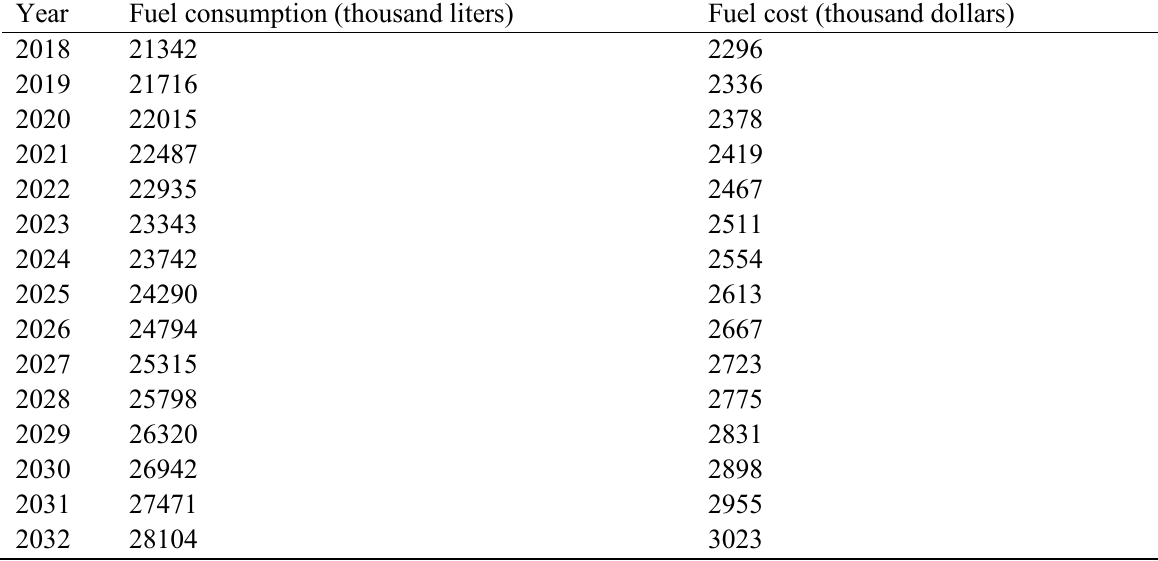
Table 6. Projected the fuel usage and costing for SWCTT in Tehran from